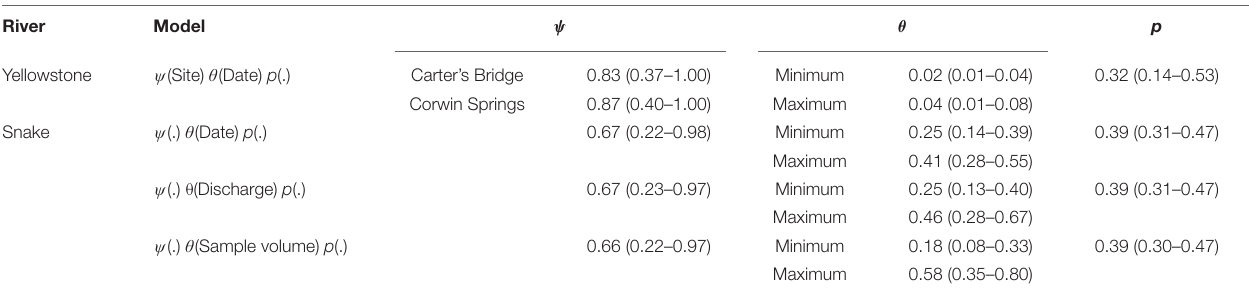
TABLE 3 | Posterior mean estimates ( ± 95% CI) of ψ , θ , and p from the candidate models with the lowest WAIC